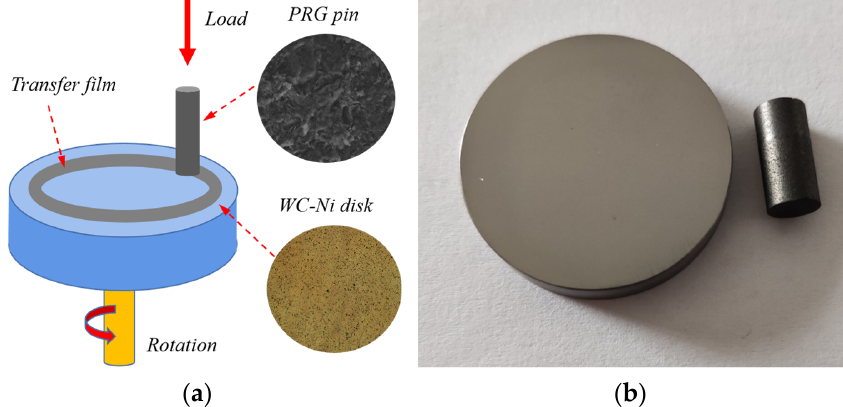
Figure 1. ( a ) Schematic diagram of sliding friction test; ( b ) Photo of PRG pin and WC-Ni disk.